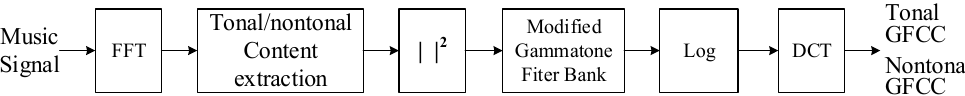
Figure 4. Extraction process of the tonal gammatone frequency cepstral coefficients (GFCC) and nontonal GFCC.